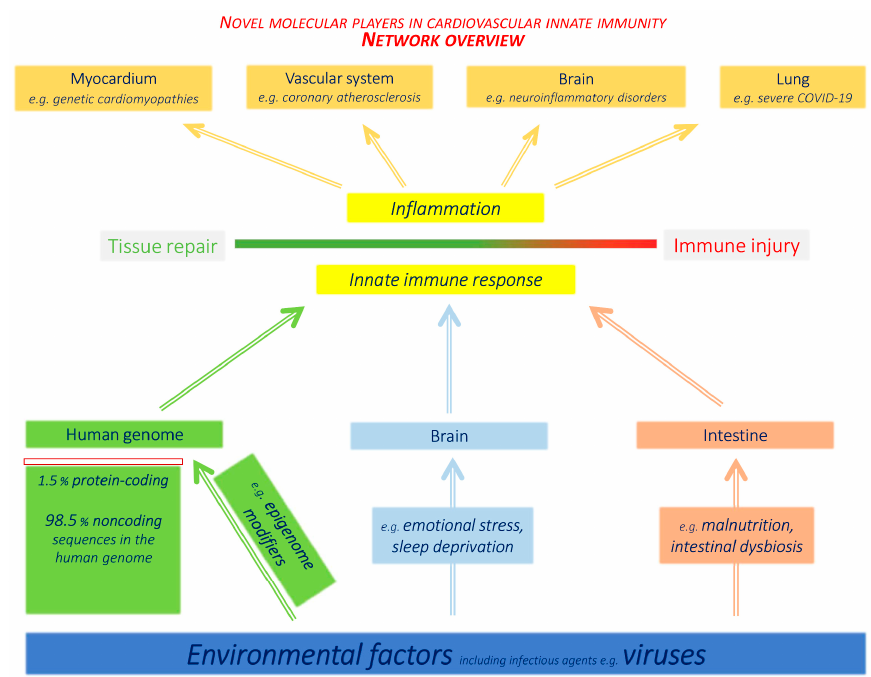
Figure 7. Novel molecular players in cardiovascular innate immunity—an overview of systems in- volved. Several systems acting through innate immunity upon cardiovascular diseases have come under intense scrutiny, taking advantage of advanced research tools. (1) Novel molecular compo- nents of the human noncoding genome and epigenome emerged as modulators of immunity acting through non-canonical pathways. (2) The intestinal immune system and microbiome exert a far- reaching impact upon distant tissues (cardiovascular system, brain). (3) Brain–immune system in- teraction networks are becoming revealed at unprecedented resolution. (4) Classical environmental risk factors, e.g., psychosocial stress or viral infections, are under intense investigation, again trig- gered by the SARS-CoV-2 pandemic with major direct and indirect impact upon cardiovascular health. In all of these fields, recent insights into human molecular genetics, as well as advanced genetic research tools, made major contributions. 5. Clinical Perspectives of Recent Studies into Novel Immune Mechanisms 5.1. Recognition of High Genetic Risk for Severe COVID-19 or Cardiovascular Involvement One of the most vexing features of SARS-CoV-2 infections [298] is the extraordinary variability of clinical consequences, ranging from asymptomatic to pneumonia and acute respiratory distress syndrome. Of course, variable clinical course is common in diverse viral diseases, but rarely to such an extent as observed with SARS-CoV-2. Established host factors such as high age or body-mass index or concomitant diseases correlate with dis- ease severity, but do not explain all of the variability observed across individuals. These observations have driven most extensive research into genetic factors contributing to COVID-19 susceptibility and severity [163,170–173,193–200], and the wish to identify oth- erwise healthy individuals at high genetic risk for severe COVID-19 will persist, whatever progress regarding prophylaxis or treatment options is made.